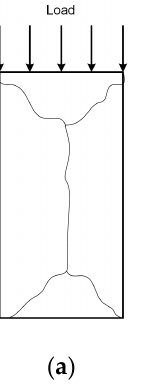
Figure 1. Typical fracture schemes: ( a ) monotonic test; ( b ) cyclic test.